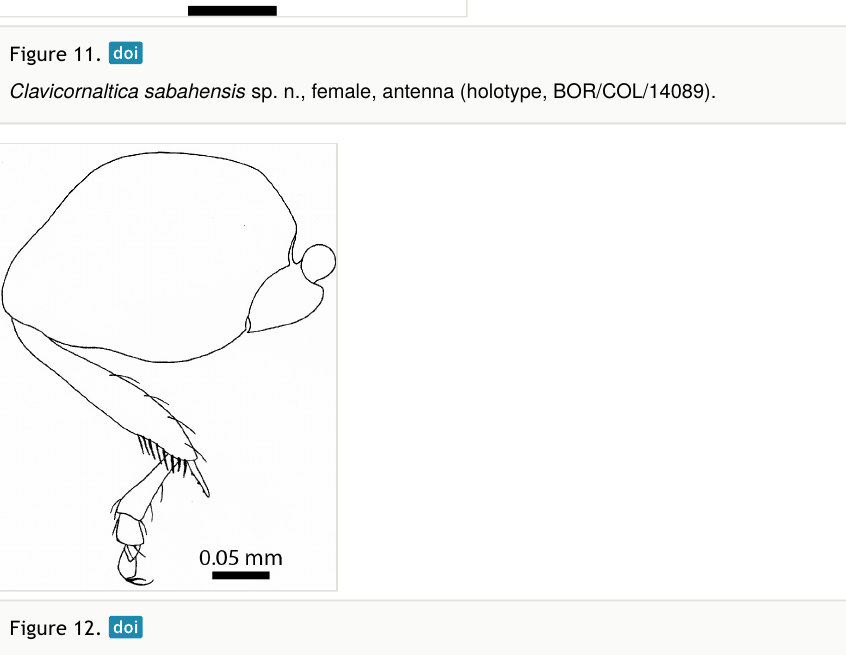
Figure 12. Clavicornaltica sabahensis sp. n., female, hind leg (holotype,